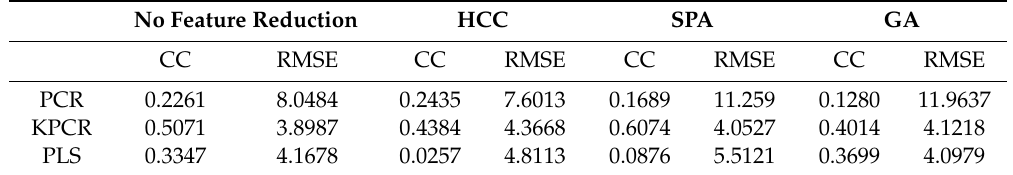
Table 2. Comparison of prediction e ff ect between hyperspectral data and seedling length for corn